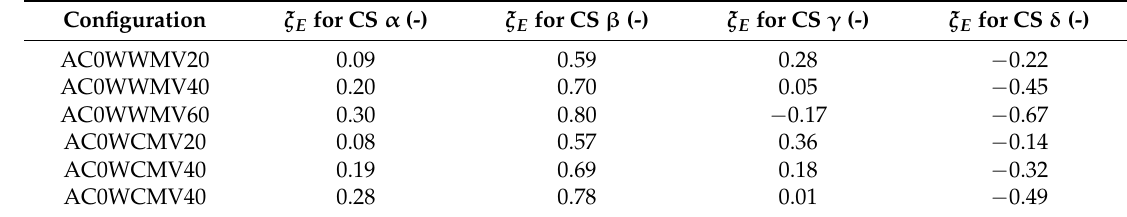
Table 6. Mass sealing effectiveness coefficient of the two best air curtain configurations.